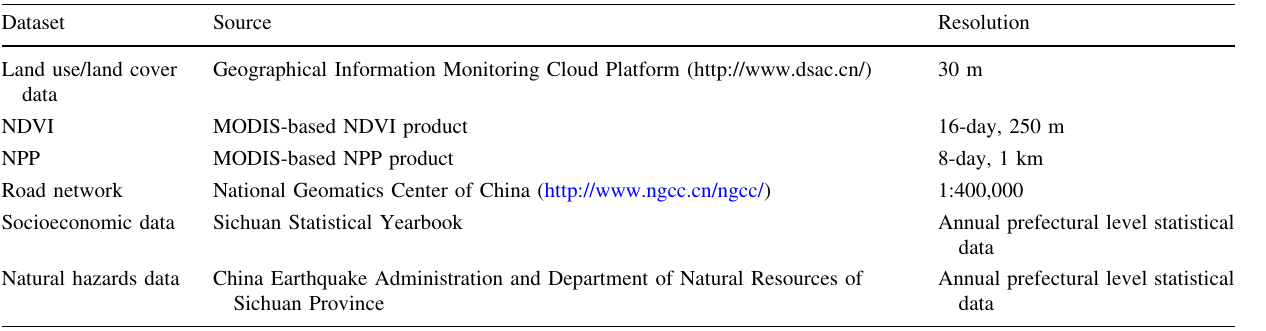
Table 1 Information of dataset used in this study